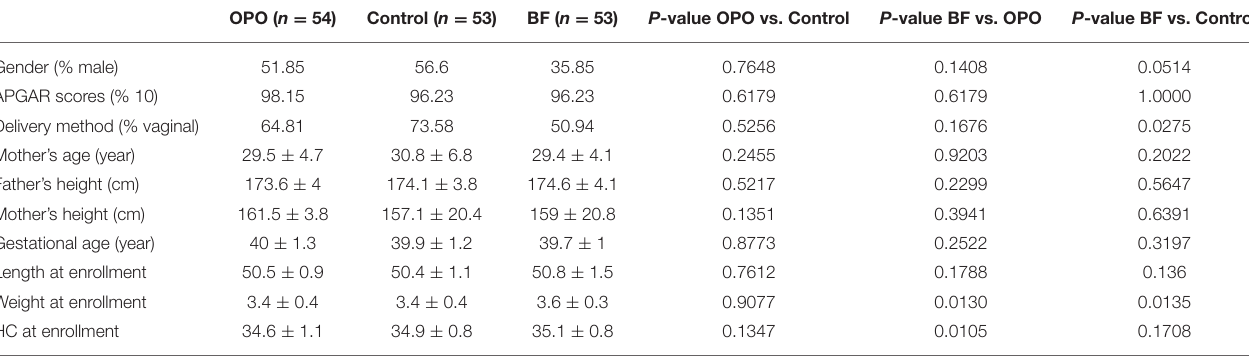
TABLE 2 | Demographic and baseline characteristics. OPO ( n = 54) Control ( n = 53) BF ( n = 53) P -value OPO vs. Control P -value BF vs. OPO P -value BF vs.